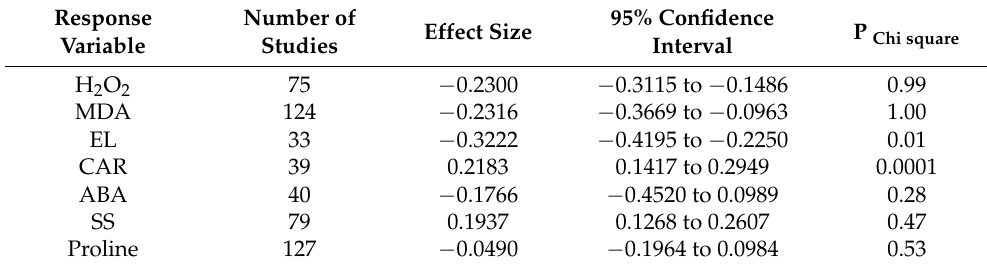
Table 1. Effect of arbuscular mycorrhizal inoculation responses on non-enzymatic antioxidants under drought stress.